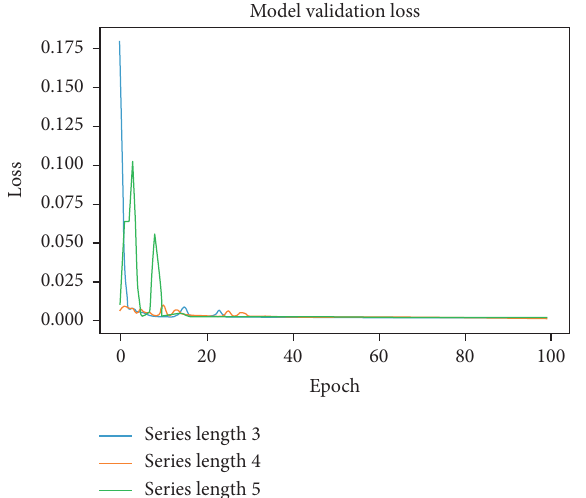
Figure 5: Learning curve with different lengths of temperature data map series.